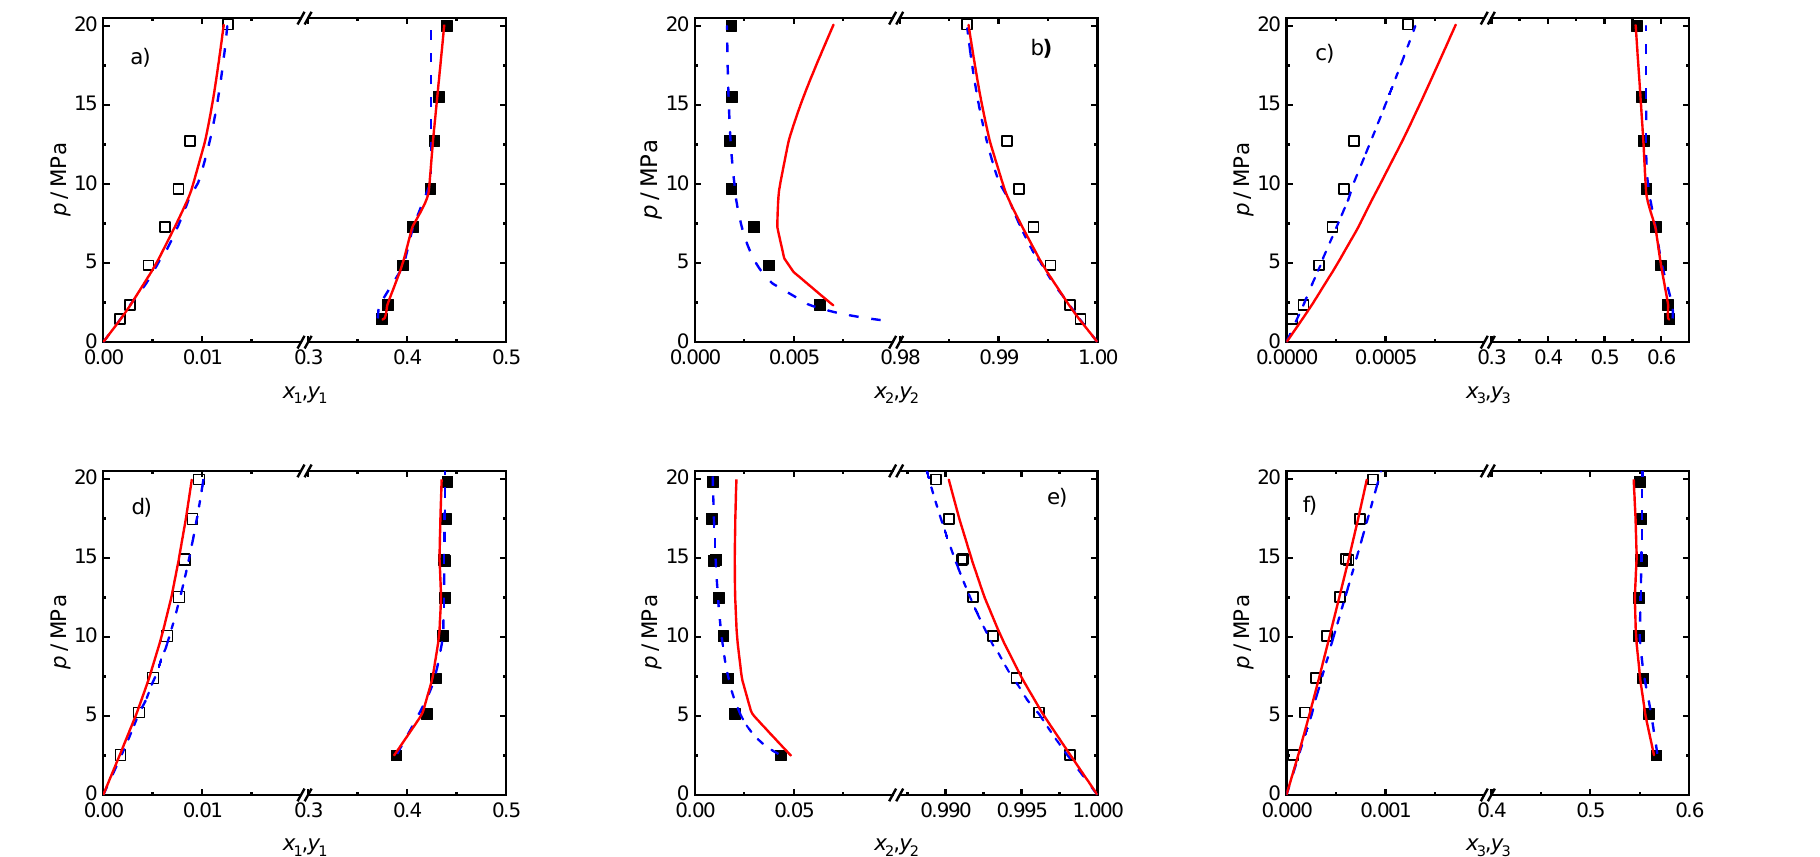
Figure 6. Vapour–liquid equilibrium for the (CO 2 (1) + H 2 O(2) +N 2 (3)) system at temperatures of ( a – c ) 323 K and ( d – f ) 373 K. Empty symbols represent dew points, and filled-in symbols represent bubble points. The mole ratio of CO 2 /N 2 fed to the system was 1. Continuous red lines represent the description of the γ - ϕ model, and dashed blue lines represent the description of the SAFT- γ Mie